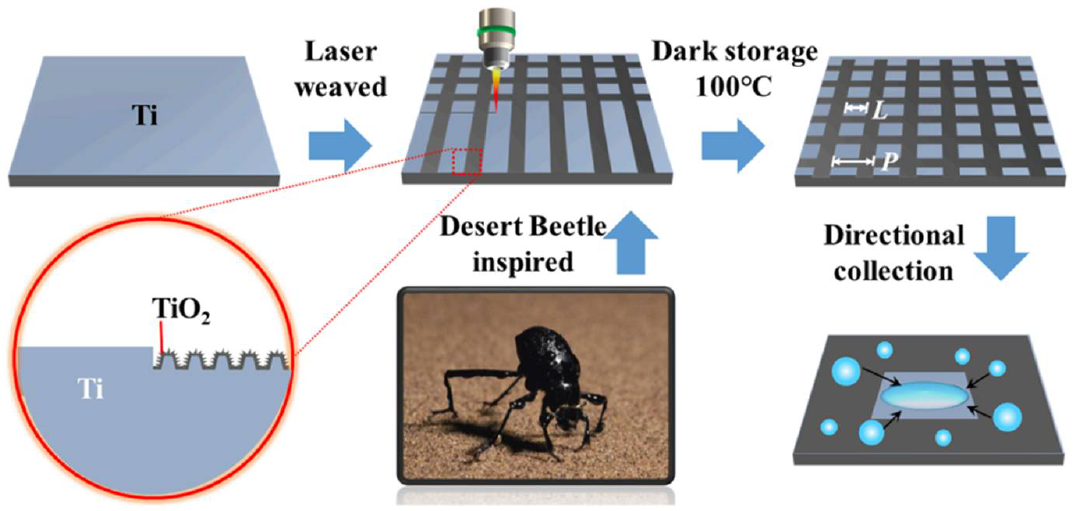
Figure 6. The schematic of femtosecond laser weaving process on a Ti surface. Reprinted with permission from Ref [54]. Copyright 2022 Elsevier.